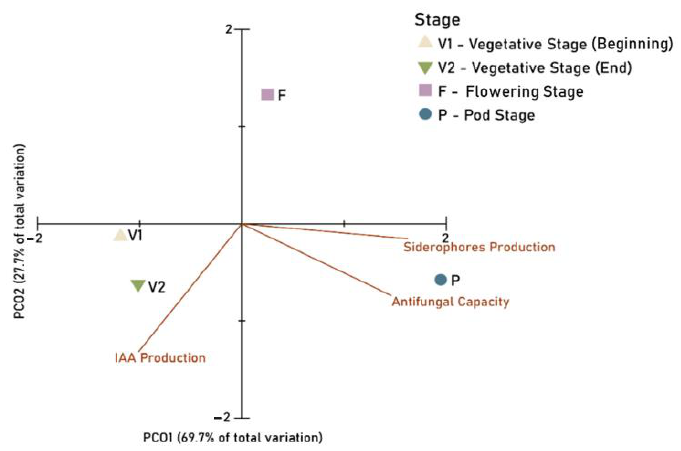
Figure 6. Principal coordinate ordination (PCO) of plant growth-promoting abilities at different stages of plant development (V1, V2, F, P). PGP traits were then superimposed.